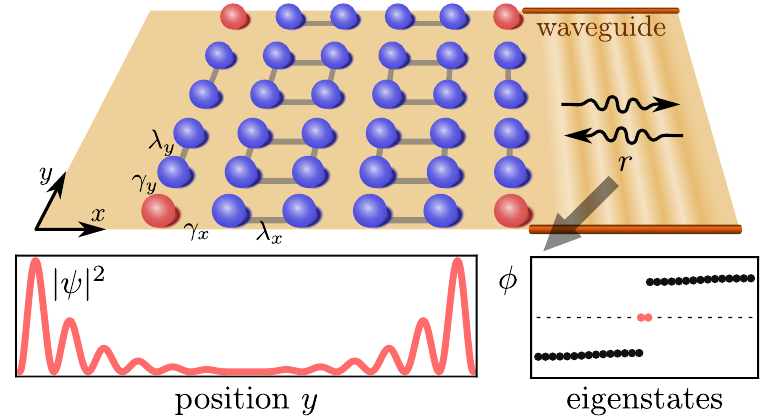
Figure 1: Scattering experiment in which a waveguide is attached to the right bound- ary of a HOTI [ Eq. (1) ] with corner states (red). Due to the gapped bulk and edges, the incoming waves are reflected. This process is described by the unitary reflection matrix r , that is topologically equivalent to the Floquet operator of a nontrivial 1D chain. The spectrum of its eigenphases φ , denoting the phase difference between incoming and reflected waves, exhibits topologically protected mid-gap states. The corresponding transversal modes ψ are localized at the boundaries of the waveguide and scatter off the corners of the 2D